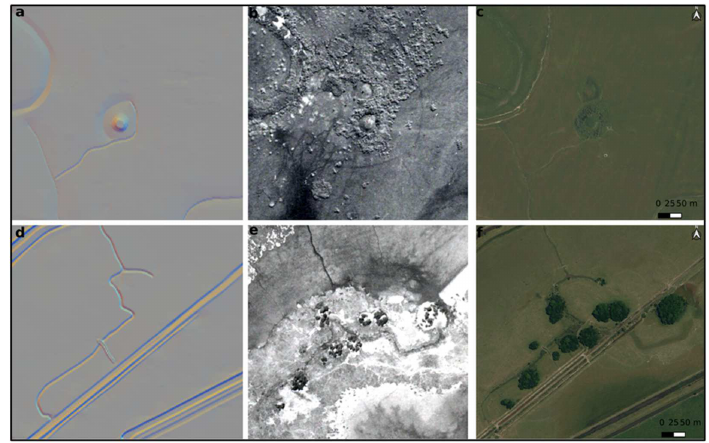
Figure 4. Documentation process of mounds and associated archaeological features using three dif- Figure 4. ferent sources of information: hillshade calculated from multiple directions. ( a , d ), Historical aerial photographs ( b , e ), and present-day orthoimages ( c , d ). Location of a mound site composed of two